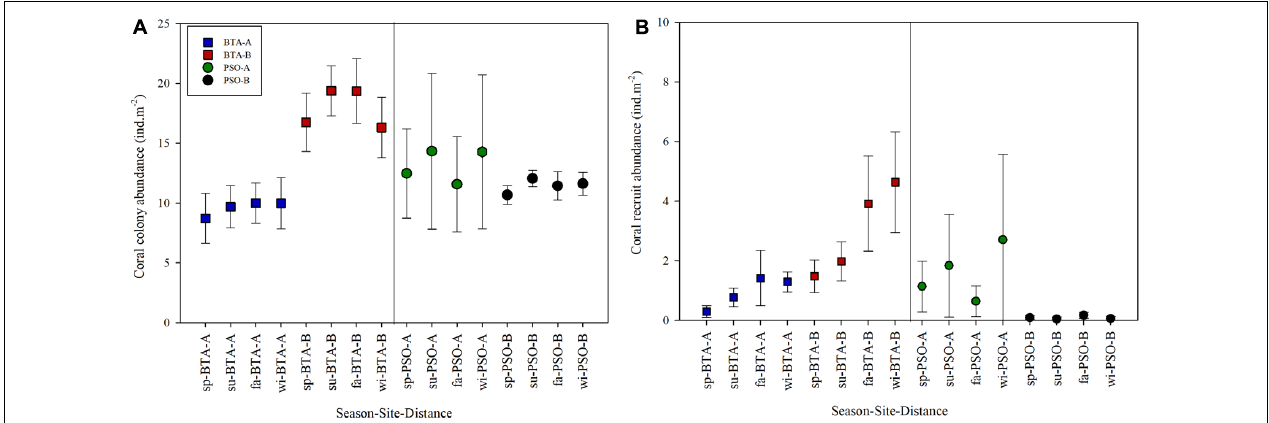
FIGURE 2 | Mean coral colony abundance (mean ± 95% CI) (A) and coral recruit abundance (B) by season, site, and distance zone. Coral abundance includes hard corals, hydrozoans and gorgonians. Blue and red squares represent Bahía Tamarindo (BTA); green and black circles represent Punta Soldado (PSO). Seasons are defined as: sp, spring; su, summer; fa, fall; wi, winter.